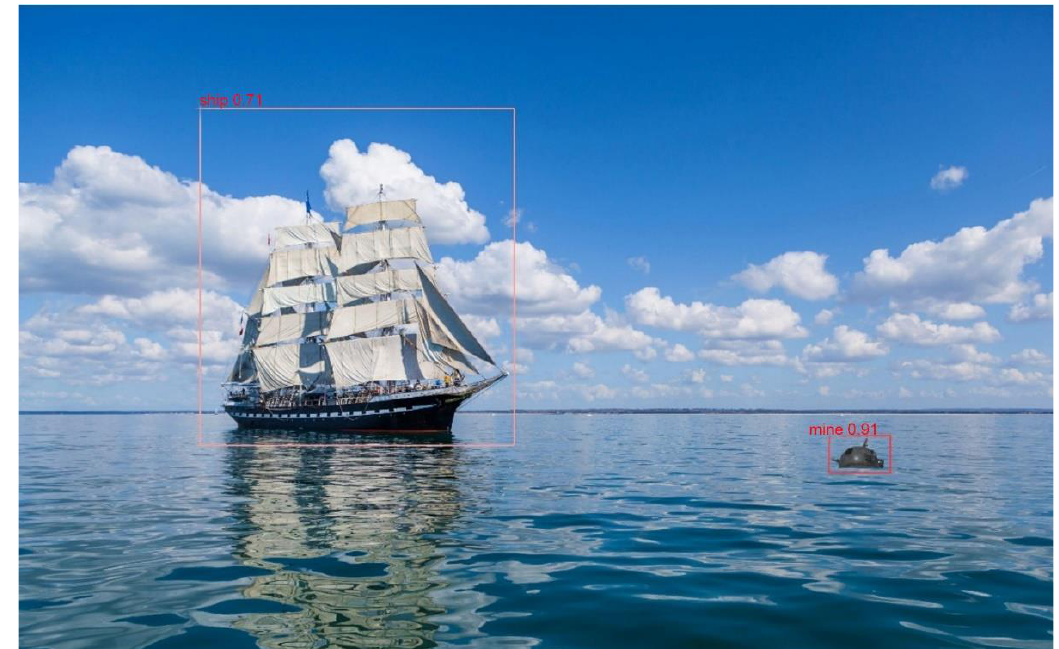
Figure 12. Metrics during YOLOv5 training.